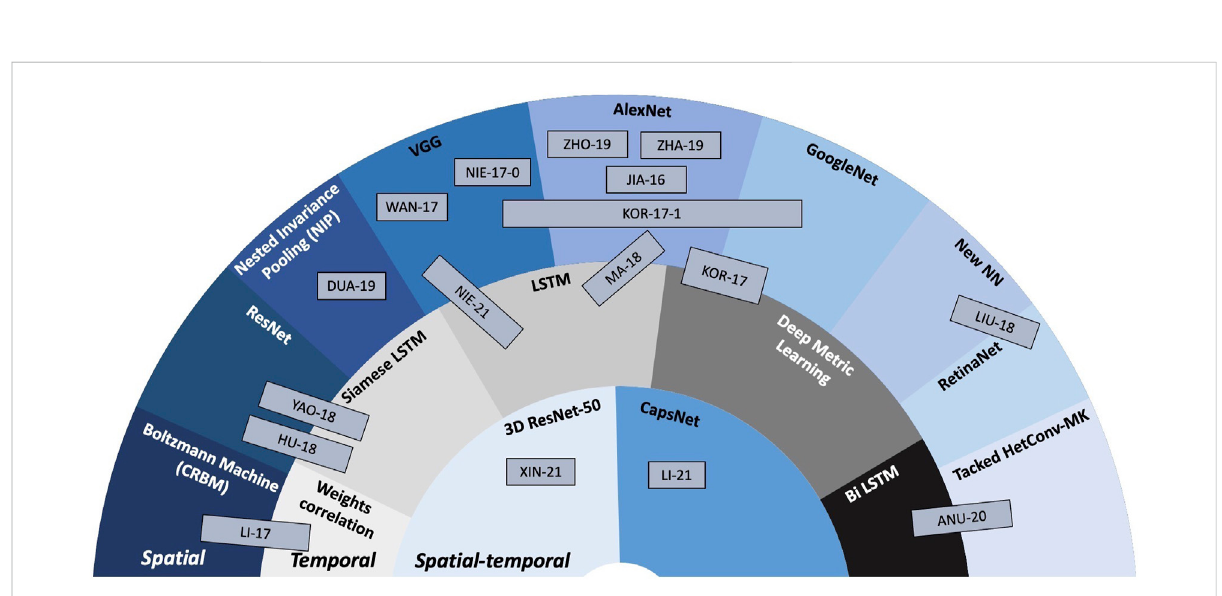
FIGURE 7 NN-based fi ngerprinting method synopsis: the hemicycles (areas) related to the spatial, temporal, and spatial-temporal features are located at the outer, middle, and inner parts of the fi gure, respectively. Inside each hemicycle, examples of state-of-the-art solutions are presented.